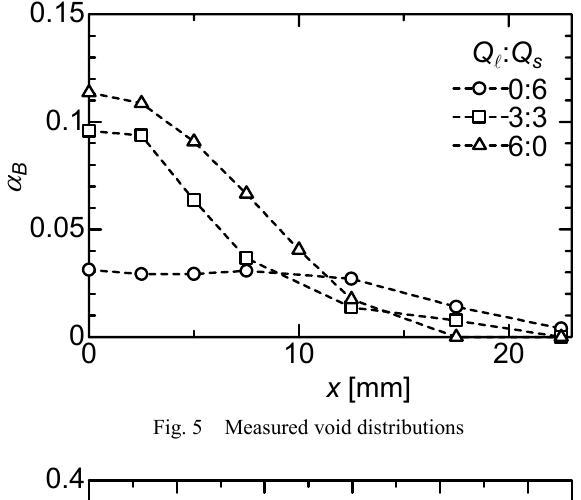
Fig. 5 Measured void distributions